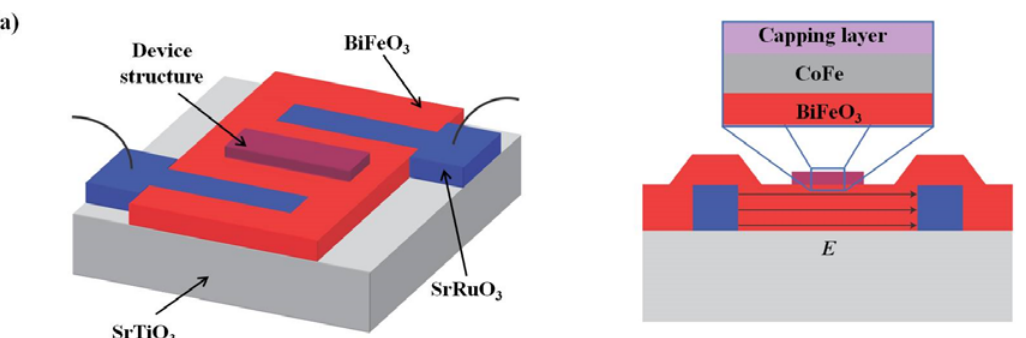
Figure 26. ( a ) Three-dimensional (left) and cross-sectional (right) schematic diagrams of the coplanar epitaxial electrode device showing the structure that will enable controlled ferroelectric switching and electrical control of local ferromagnetism in the CoFe features [576]; ( b ) XMCD–PEEM images taken at the Co L-edge revealing the ferromagnetic domain structure of the CoFe features in such a coplanar electrode device structure in the as-grown state (left), after the first electrical switch (middle) and after the second electrical switch (right)